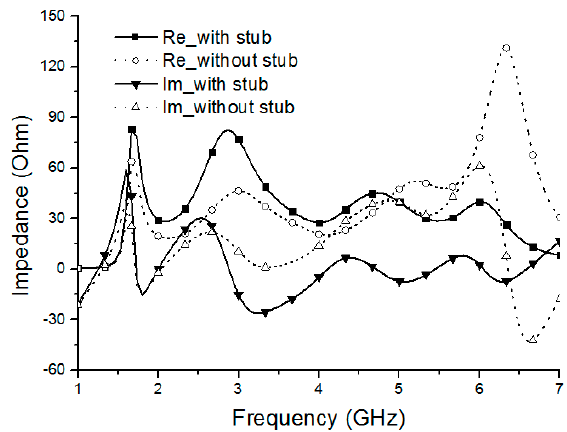
Figure 2. Comparison of the input impedance between the antenna with and without the high-impedance stub (i.e., with stub and without stub).